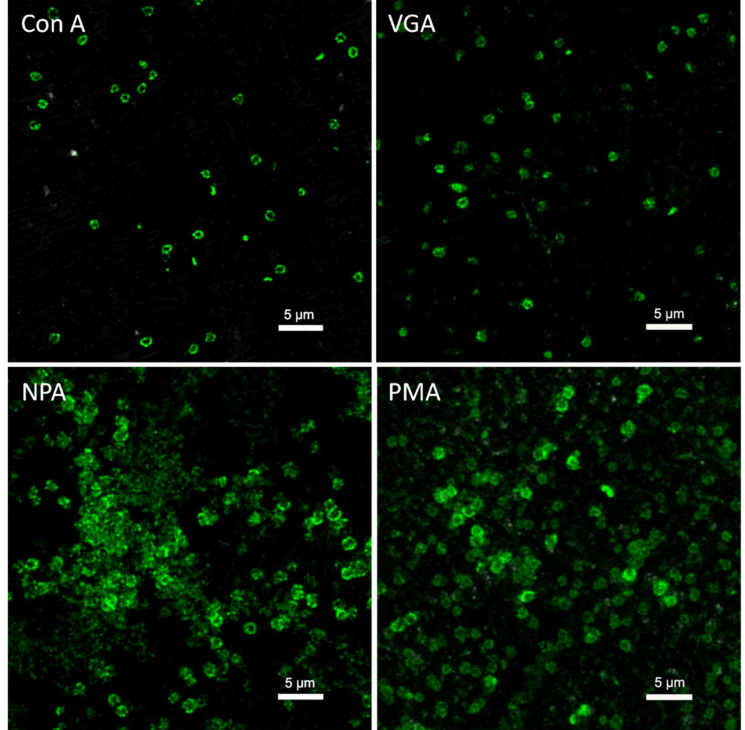
Figure 5. Images of Sulfolobus metallicus T biofilms on elemental sulfur stained by Fluorescein isothio- cyanate (FITC)-labeled lectins Con A, VGA, NPA ( Narcissus pseudonarcissus ), and PMA ( Polygonatum multiflorum ) are shown. Images were reproduced from [104] with permission from Springer